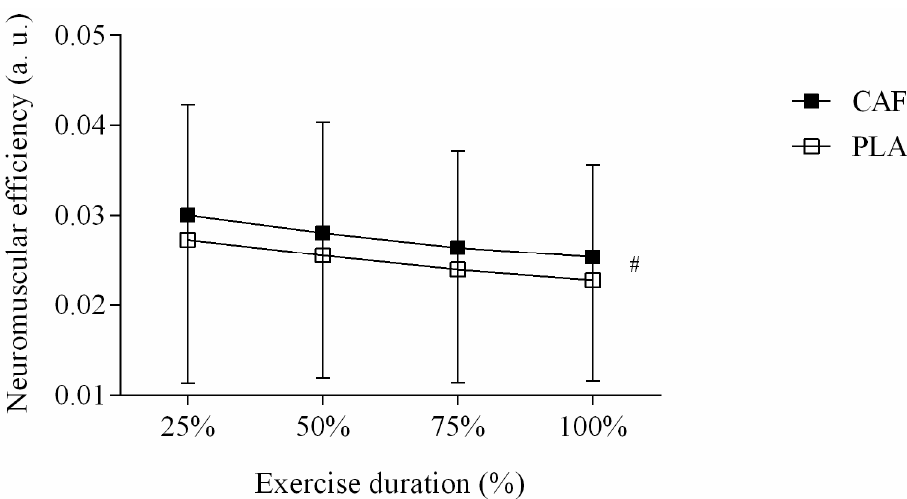
Figure 3. Changes in neuromuscular efficiency (NME) of vastus lateralis muscle during isometric contraction in caffeine (CAF) and placebo (PLA) sessions. # Is moment main effect ( p = 0.000). Data are reported as mean ± SD.